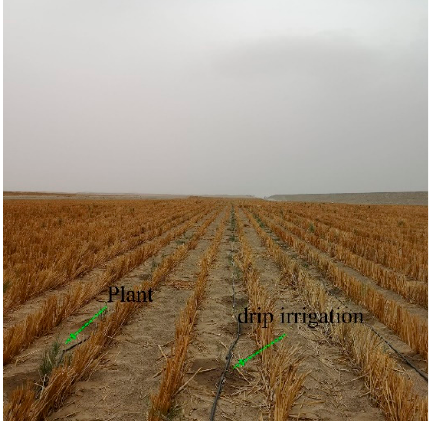
Figure 13. Setting of shelter forest belts along the railway.